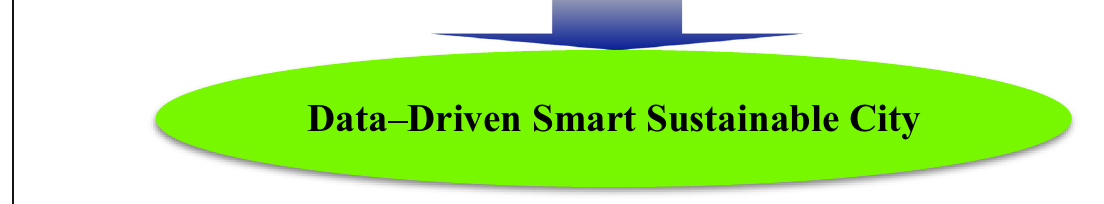
Fig. 2 A framework for the data-driven smart sustainable city. Source: Adapted from Bibri